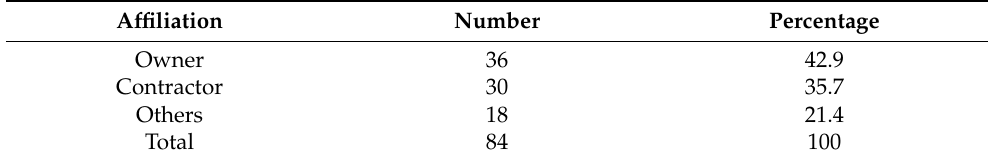
Table 2. Profile of respondents’ affiliation.